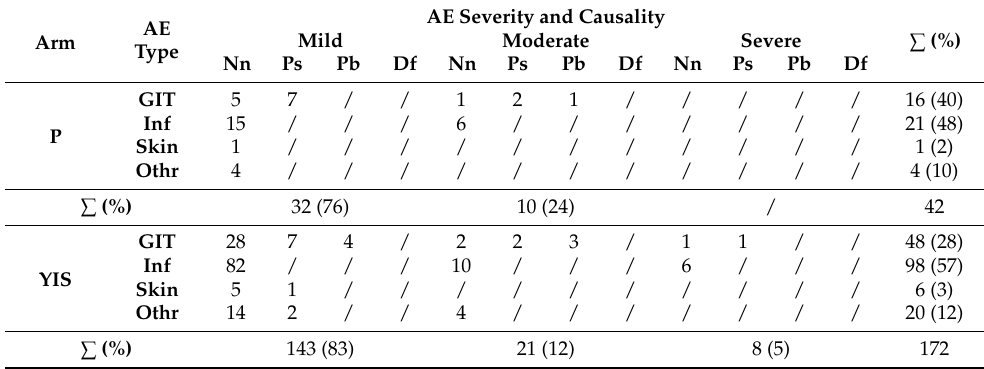
Table 3. Frequency and severity of reported adverse